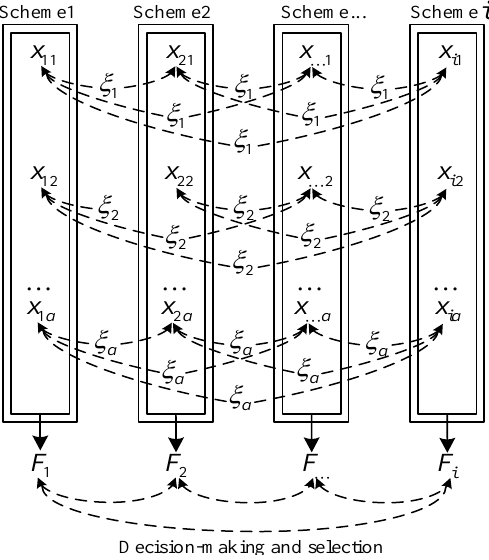
Figure 5. Decision-making and selection process of Regret Theory.